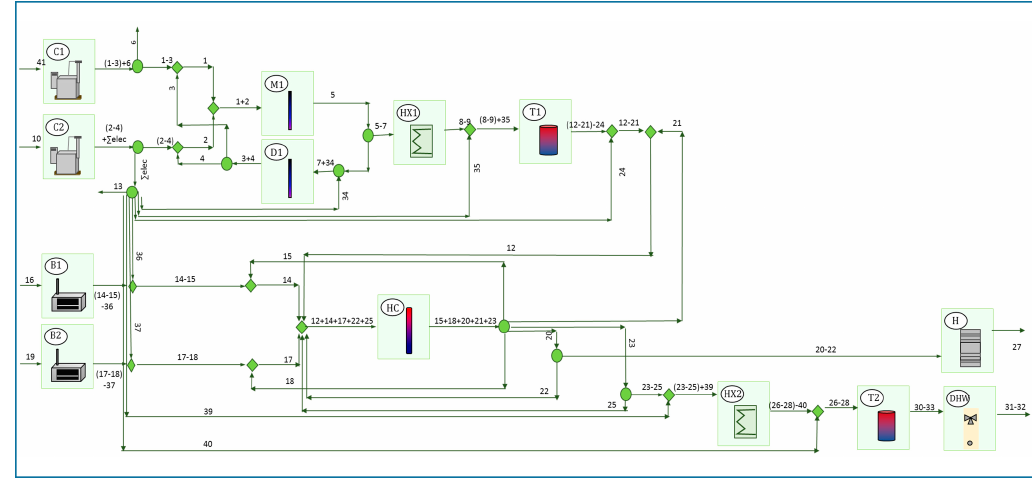
Figure 7. Productive structure of the system.